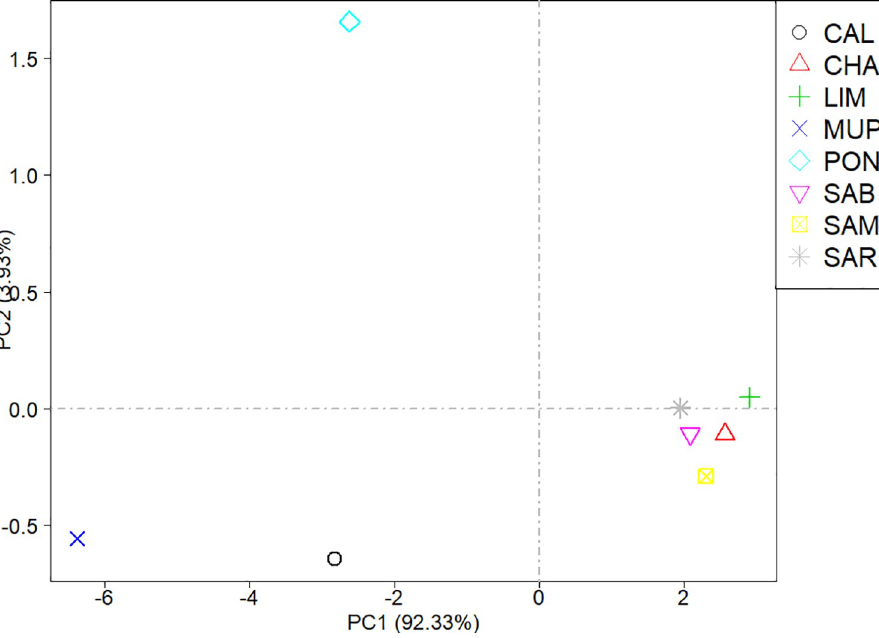
Fig 4. Scatterplot of the first two principal components (PCs). Principal component analysis (PCA) was performed on the number of identified ROH per chromosome in each breed. CAL = Calvana; CHA = Charolais; LIM = Limousine; MUP = Mucca Pisana; PON = Pontremolese; SAB = Sardo Bruna; SAM = Sardo Modicana; SAR =